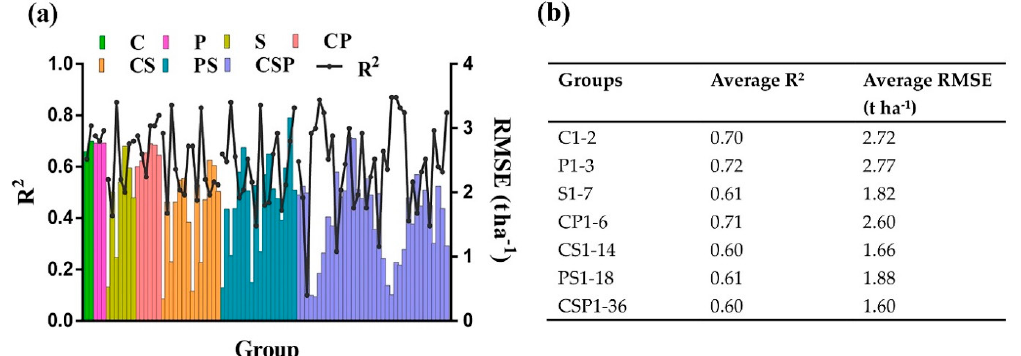
Figure 10. Comparison of predictive capability within the groups of LME models (for AGB estimation) using different random effects: ( a ) the R 2 and RMSE of the groups of different random effects; ( b ) the average R 2 and RMSE of the groupings of different random effects. C represents cultivar; P represents planting pattern; S represents growth stage; CP represents combination of cultivar and planting pattern; CS represents combination of cultivar and growth stage; PS represents combination of planting pattern and growth stage; CSP represents combination of cultivar, growth stage and planting pattern.